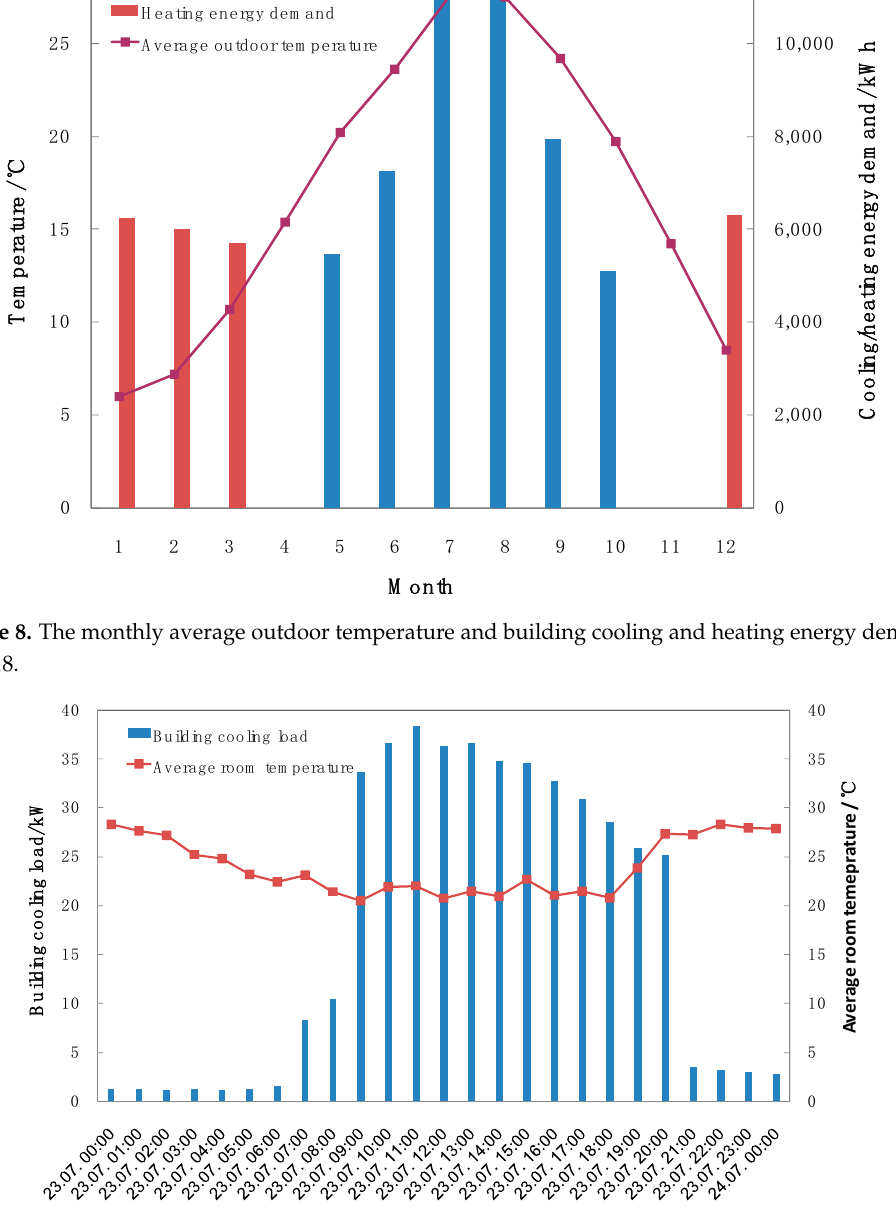
Figure 9. The hourly building cooling load and average room temperature on 23 July Figure9. The hourly building cooling load and average room temperature on 23 July 2018.